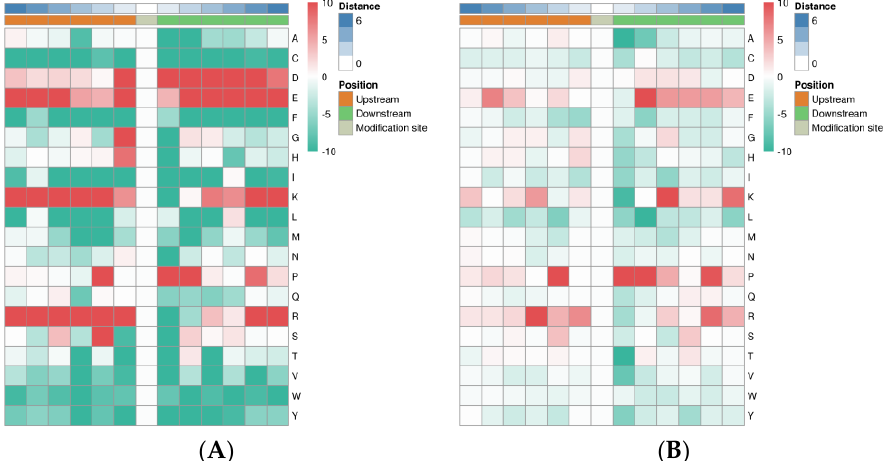
Figure 7. Motif enrichment heat maps of phospho-serine ( A ) and phospho-threonine ( B ) upstream and downstream of all identified phosphorylated modification sites. Red indicates significant enrichment of the amino acid near the modification site, while green indicates significant reduction of the amino acid near the modification site.